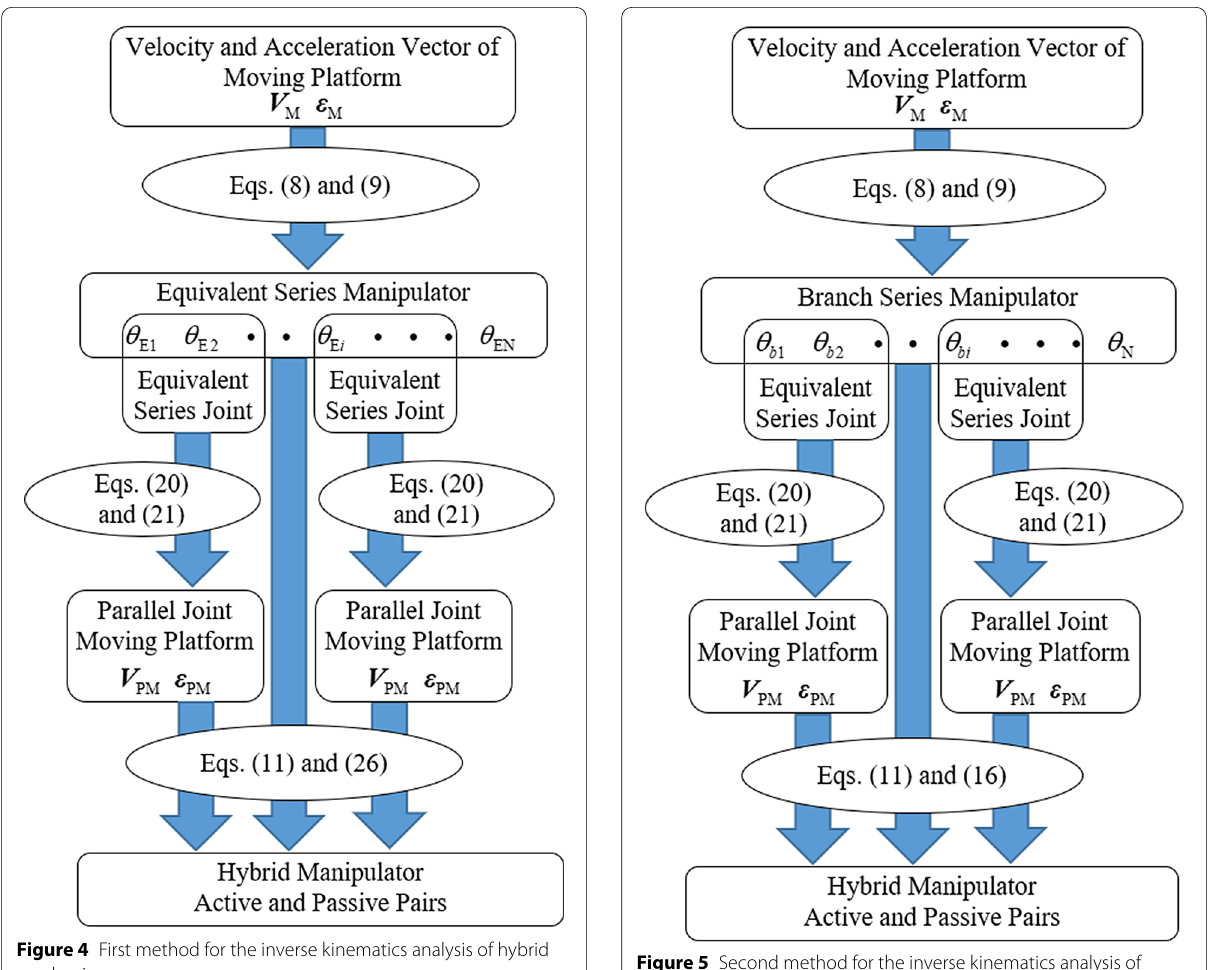
Figure 5 Second method for the inverse kinematics analysis of hybrid